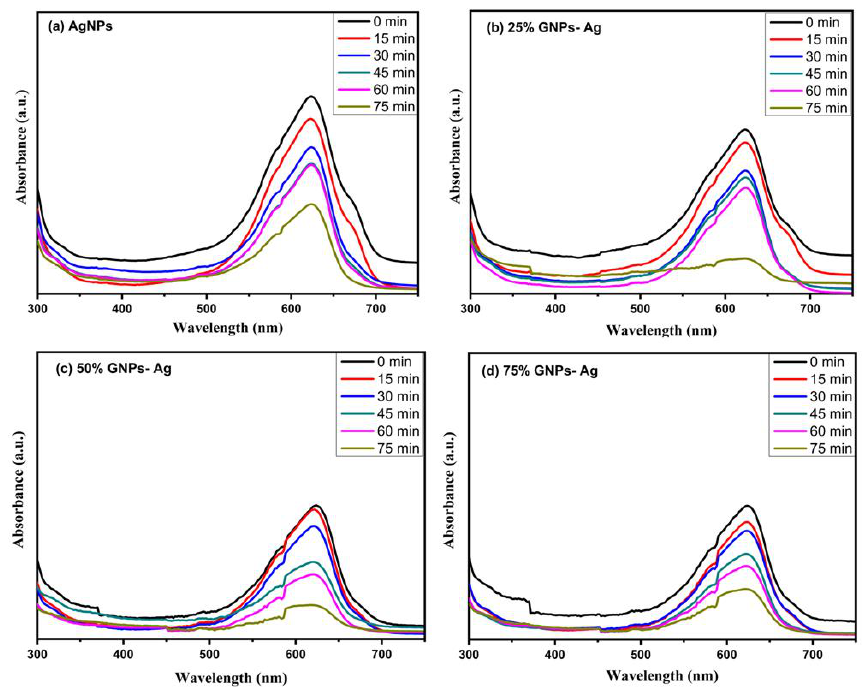
Figure 12. Photocatalytic degradation of MB under visible light irradiation at different time intervals with ( a ) AgNPs, ( b ) 25% GNPs-Ag nanocomposite, ( c ) 50% GNPs-Ag nanocomposite and ( d ) 75% GNPs-Ag nanocomposite.